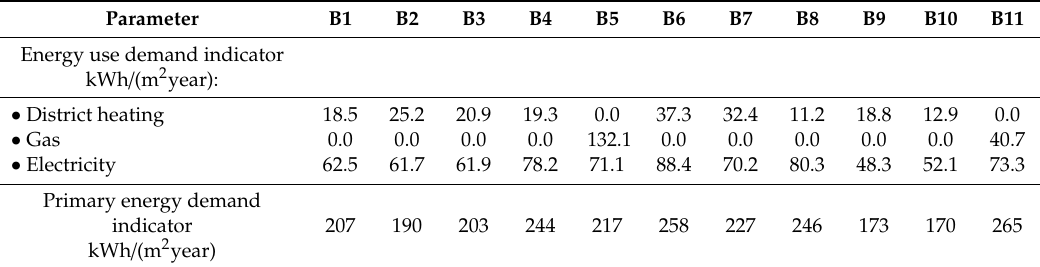
Table 5. Energy use and primary energy